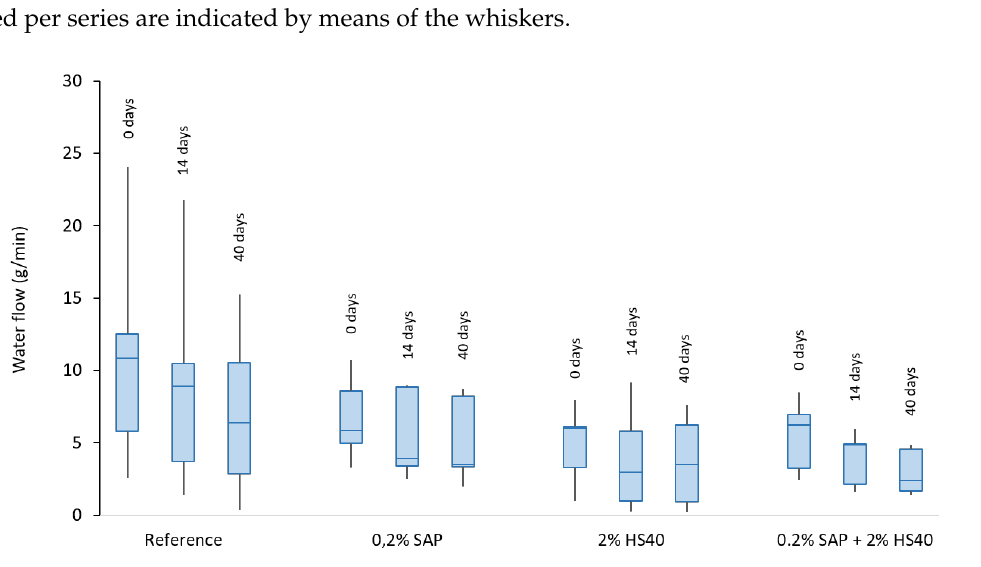
Figure 7. Average water flow of all series measured at 0, 14 and 40 days of wet–dry cycles. The boxes show the first, second and third quartile, being the lower, middle and upper line, respectively. The whiskers determine the minimum and maximum values